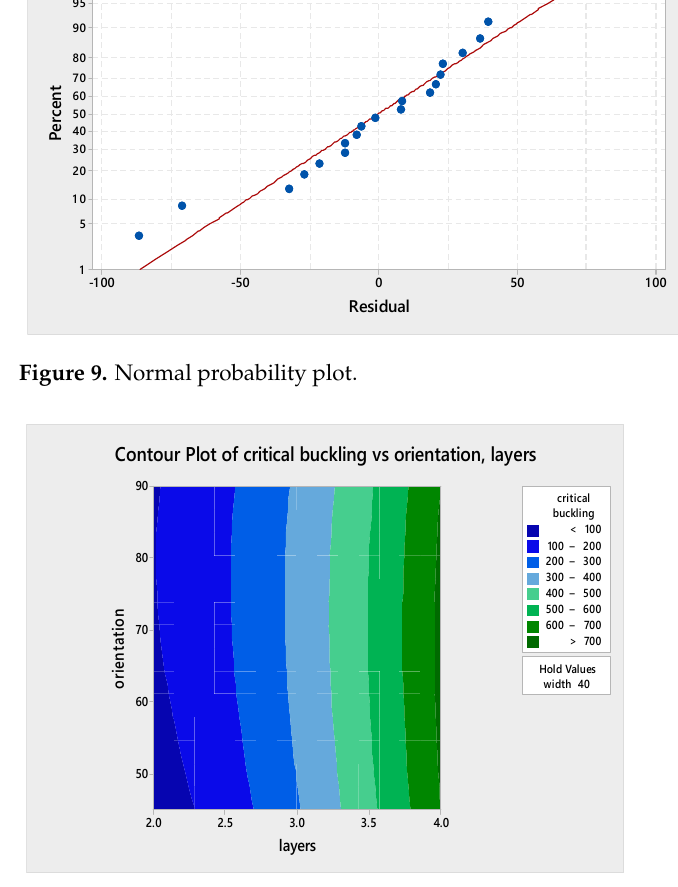
Figure 10. Contour plot of critical buckling versus orientation, layers. Contour Plot of critical buckling vs orientation, width